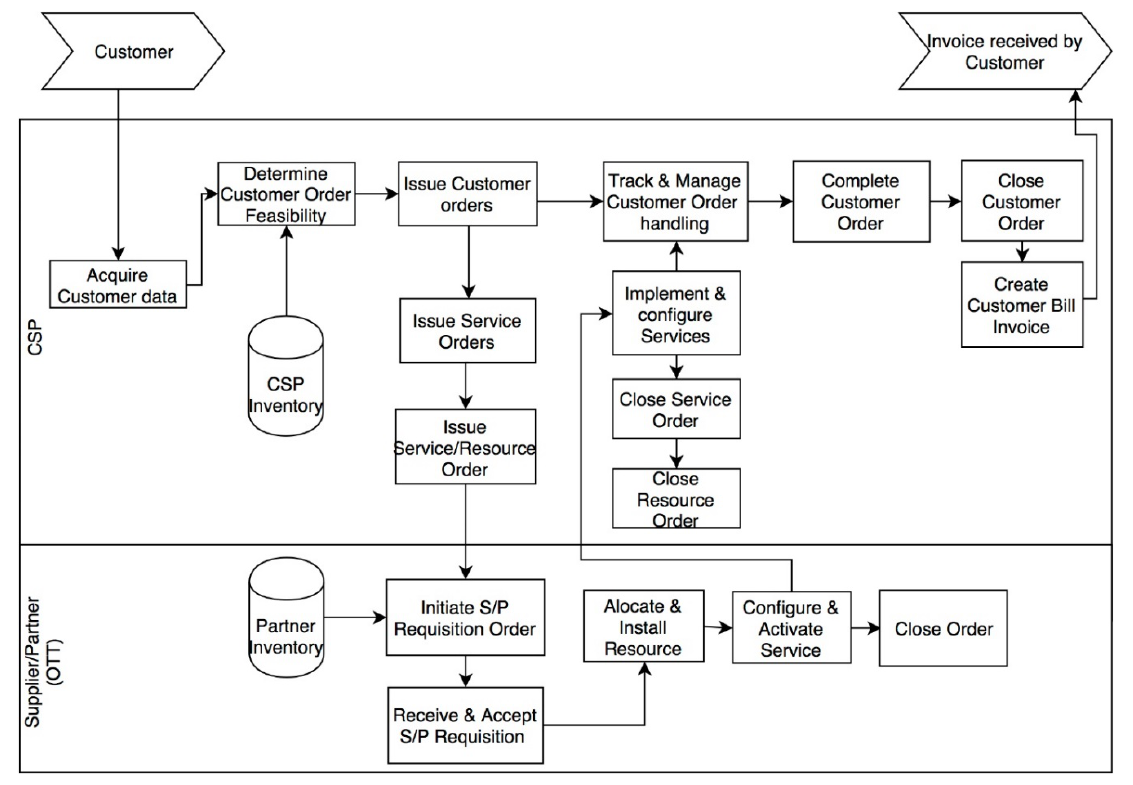
Figure 4. Level 3 - Process elements in Order-to-payment. Adapted from: (TM Forum, 2012)